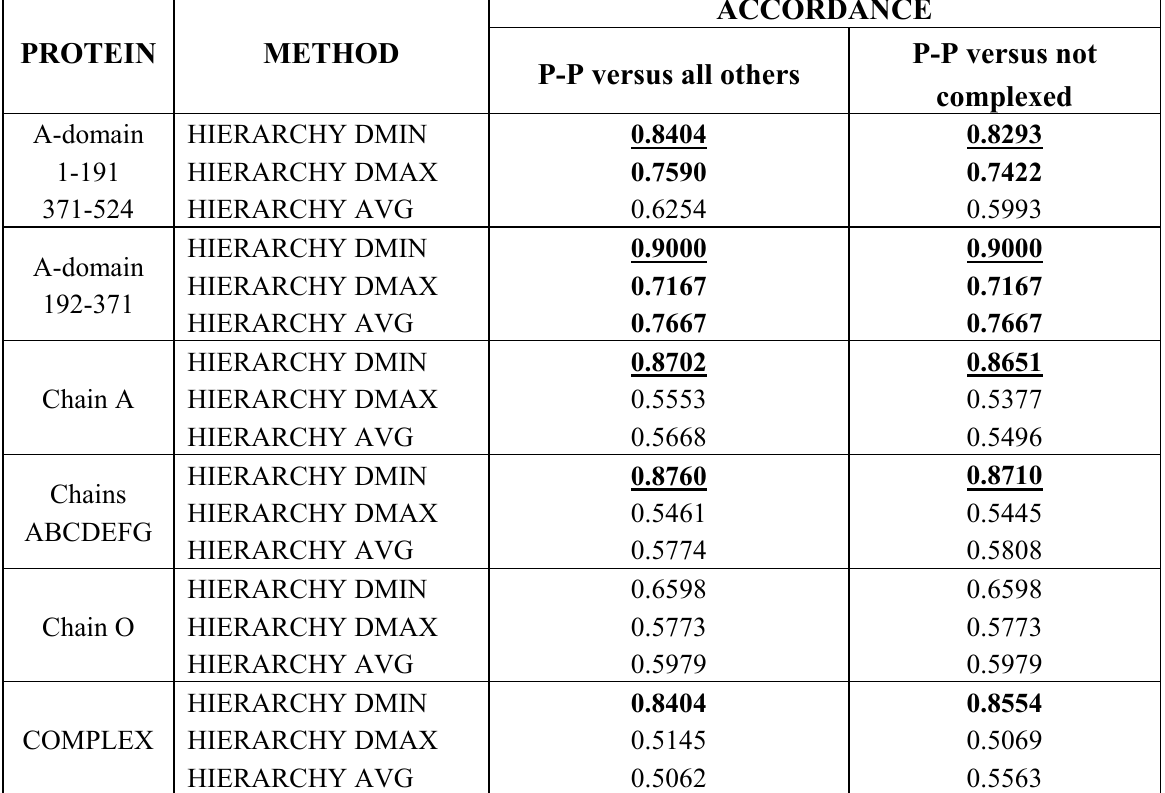
Table 1. Accordance between expected clustering and observed one for classification between amino acids engaged in protein-protein complexation versus all others (not engaged in protein-protein interaction) – third column and amino acids engaged in protein- protein complexation versus those which are not in protein-protein contact (the residues engaged in ligand or ion binding excluded). P-P denotes the residues engaged in protein- protein